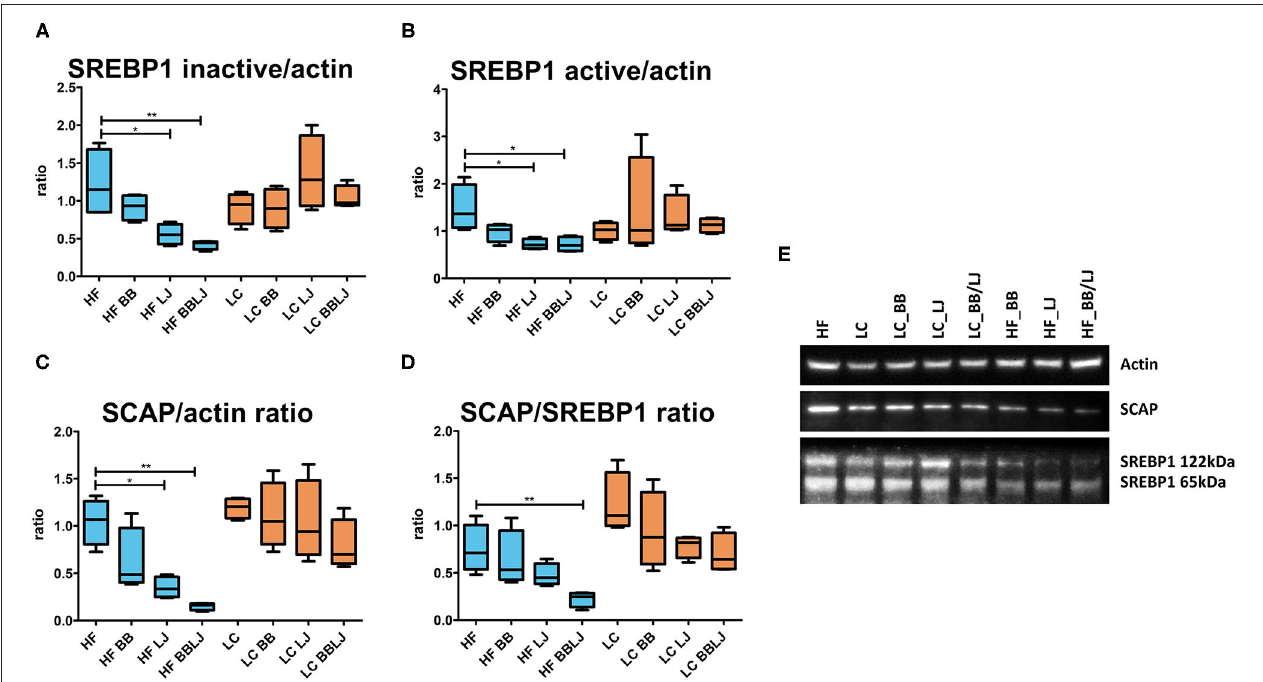
FIGURE 7 | SREBP1 and SCAP protein levels determined via western blot. β -actin levels were used as a loading control. (A,B) Ratios of the inactive (122 kDa) and active (65 kDa) forms of SREBP1 over β -actin (42 kDa) band intensity, respectively. (C) Ratio of SCAP over actin band intensity and (D) over the active form of SREBP1. (E) Representation of the band intensity of SREBP1, SCAP, and β -actin from each treatment group. n = 4 from 3 independent experiments. HF, high-fat diet; LC, low-calorie diet; BB, blueberry extract; LJ, L. johnsonii N6.2; BB/LJ, blueberry extract + L. johnsonii N6.2. Blue bars: animals under HF diet; orange bars: animals under LC diet. * p -value < 0.05; ** p -value <